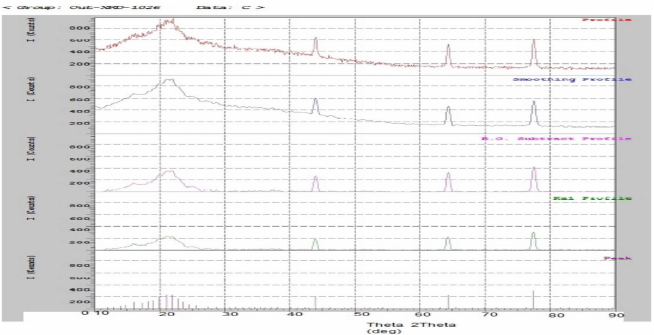
Figure 7. XRD analysis of mucilage